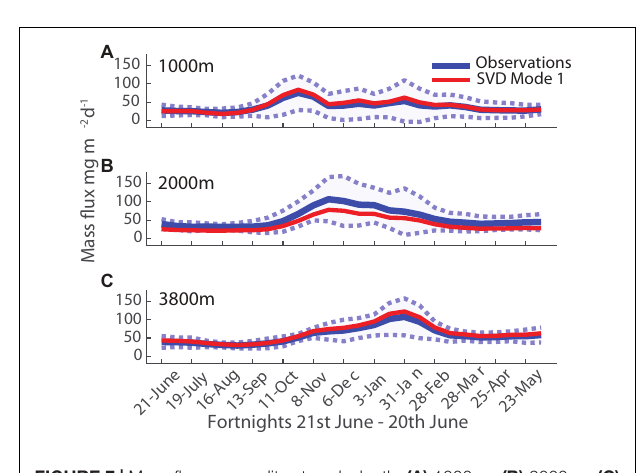
FIGURE 7 | Mass flux seasonality at each depth: (A) 1000 m, (B) 2000 m, (C) 3800 m. Fortnightly averages in blue, with blue shaded area representing 1 SD. The first mode from the SVD analysis is shown in